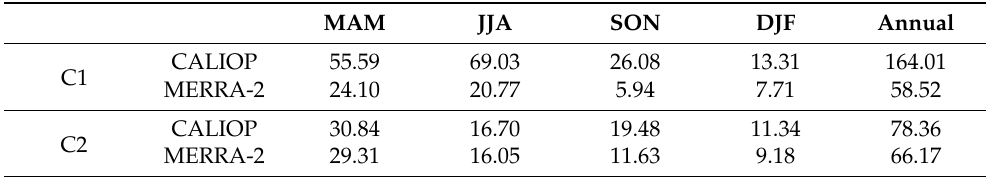
Table 1. Dust transport contribution (unit: Tg) from Central Asia to South Asia (C1) and East Asia (C2) based on CALIOP observation and MERRA-2 reanalysis data. MAM JJA SON DJF C1